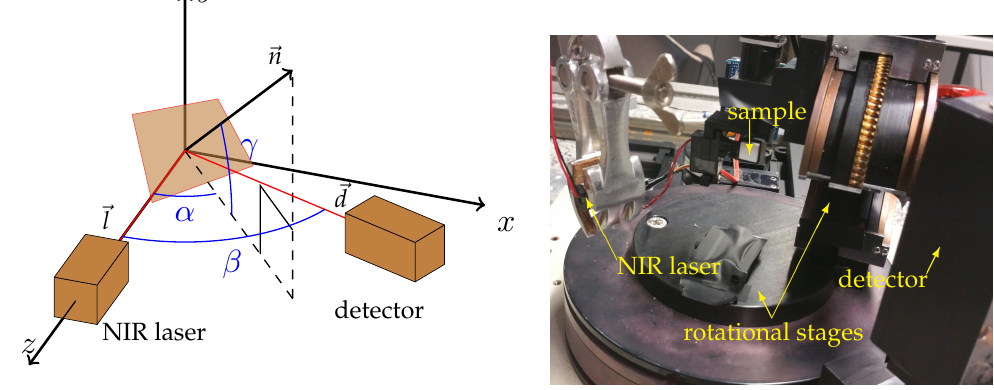
Figure 3. The schematic gonioreflectometer measurement setup (left) and a photo of the real setup (right). Our measurement setup is parameterized using the angles α = ∠ ( (cid:126) n (cid:48) , (cid:126) l ) , β = ∠ ( (cid:126) d , (cid:126) l ) and the elevation angle γ of the sample’s normal (cid:126) n . Here, (cid:126) n (cid:48) is the projection of (cid:126) n onto the (cid:126) l - (cid:126) d -plane, (cid:126) l = ( 0, 0, 1 ) T the light direction towards the NIR laser, and (cid:126) d the direction towards the